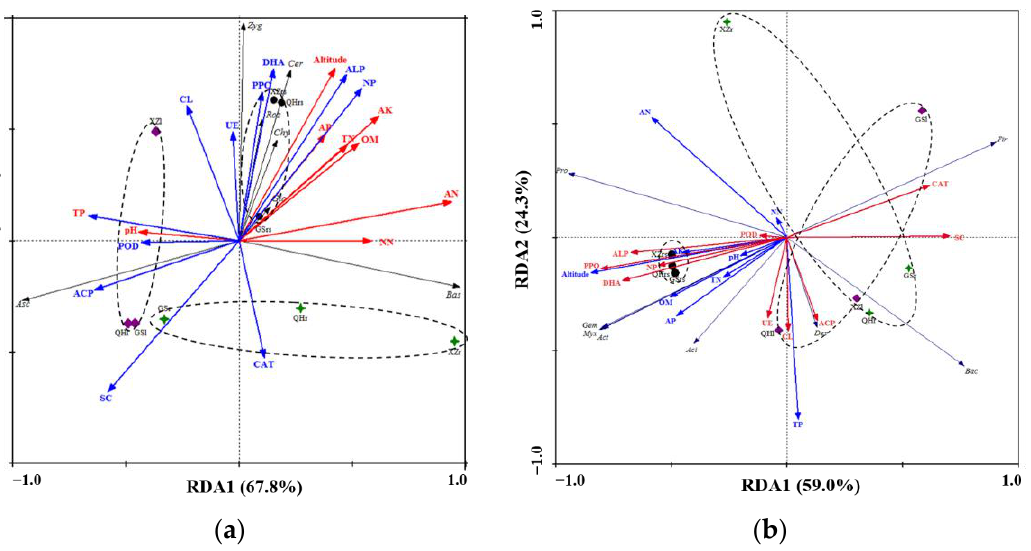
Figure 6. Correlations between soil properties and the community structure of fungi ( a ) and bacteria ( b ) as determined by redundancy